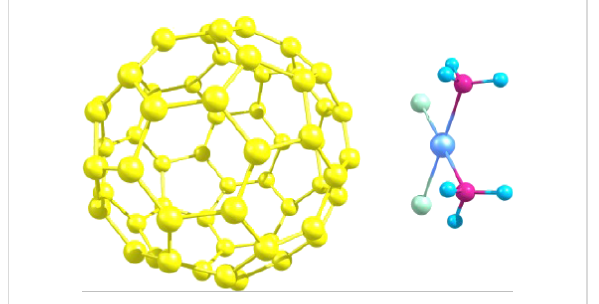
Figure 3: The calculated energy-optimized structure of the C 60 +Cis nanocomplex in aqueous solution.